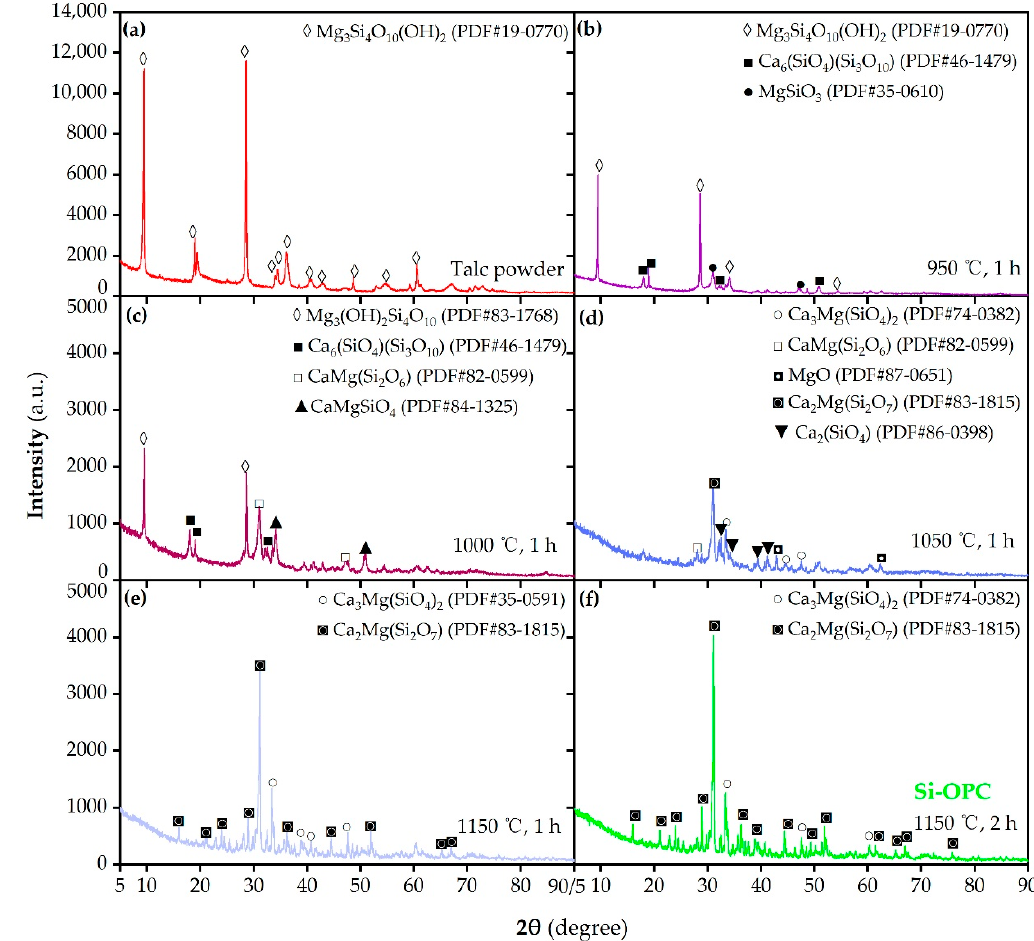
Figure 2. XRD patterns of the ( a ) talc powder and the prepared Si fertilizers after calcination at ( b ) 950 °C, ( c ) 1000 °C, ( d ) 1050 °C and ( e ) 1150 °C for 1 h, as well as ( f ) 1150 °C for 2 h (i.e., the Si-OPC). In all cases, n(Talc powder): n(CaCO 3 ) = 1:2.0.